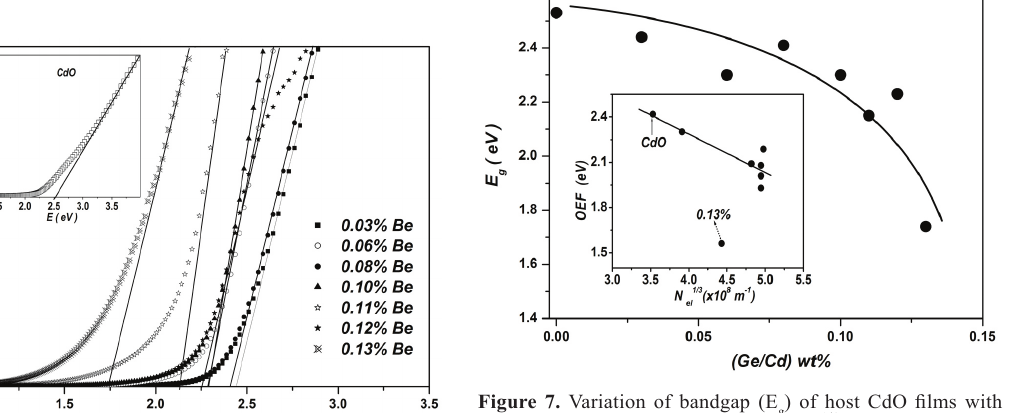
Figure 7. Variation of bandgap (E ) of host CdO films with g Be doping level. The inset shows the 1/3 el N -dependence of the (E - S N ) . The straight line shows the best OEF = 2/3 g BGW,BGN el fit according to the adopted